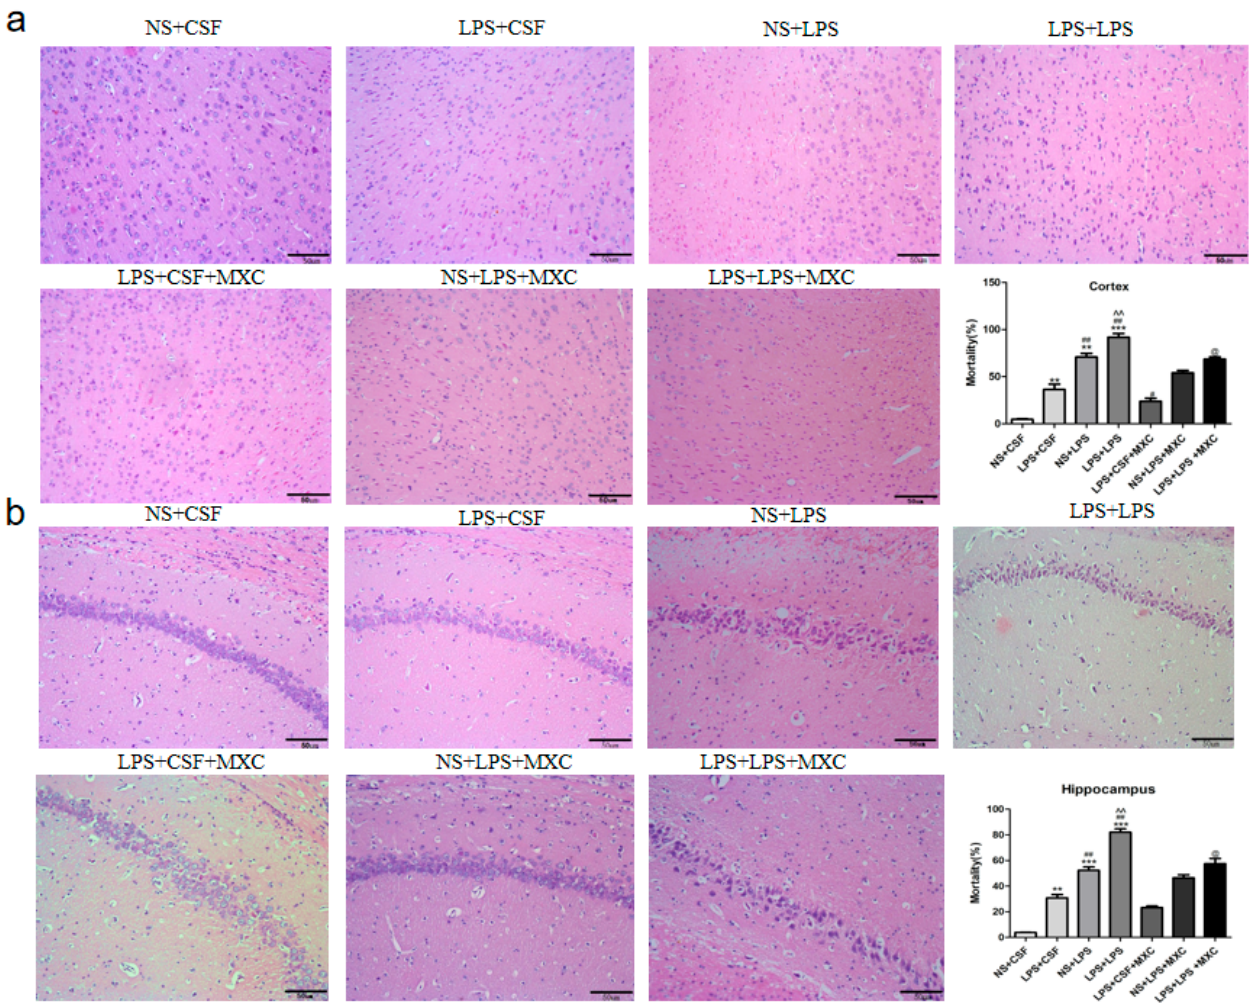
Figure 3. Effect of MXC on hippocampal and cortical histopathology in LPS-treated offspring from prenatal inflammation exposure: ( a ) Representative images of HE staining in cortex fields from NS + CSF, LPS + CSF, NS + CSF, LPS + CSF, LPS + CSF + MXC, NS + CSF + MXC, LPS + CSF + MXC groups; quantitative analysis of neuronal counts in the seven groups. Note decreased neuronal counts and enhanced neuronal damage in LPS + LPS group compared with NS + LPS group. ( b ) Representative images of HE staining in hippocampus fields from NS + CSF, LPS + CSF, NS + CSF, LPS + CSF, LPS + CSF + MXC, NS + CSF + MXC, LPS + CSF + MXC groups; quantitative analysis of neuronal counts in the seven groups. Note reduced neuronal counts and increased neuronal damage in LPS + LPS group compared with NS + LPS group. Data are mean ± SEM, n = 4. (** p < 0.01, *** p < 0.001 vs. NS + CSF group; # p < 0.05, ## p < 0.01 vs. LPS + CSF group; ^^ p < 0.01 vs. NS + LPS group; @ p < 0.05 vs. LPS + LPS group).